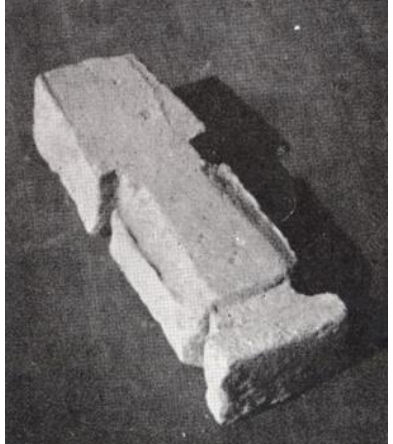
Figure 2. "Ηollow-wall peg tile" from the baths of the Sanctuary of Apollo Hylates (Scranton 1967, fig.